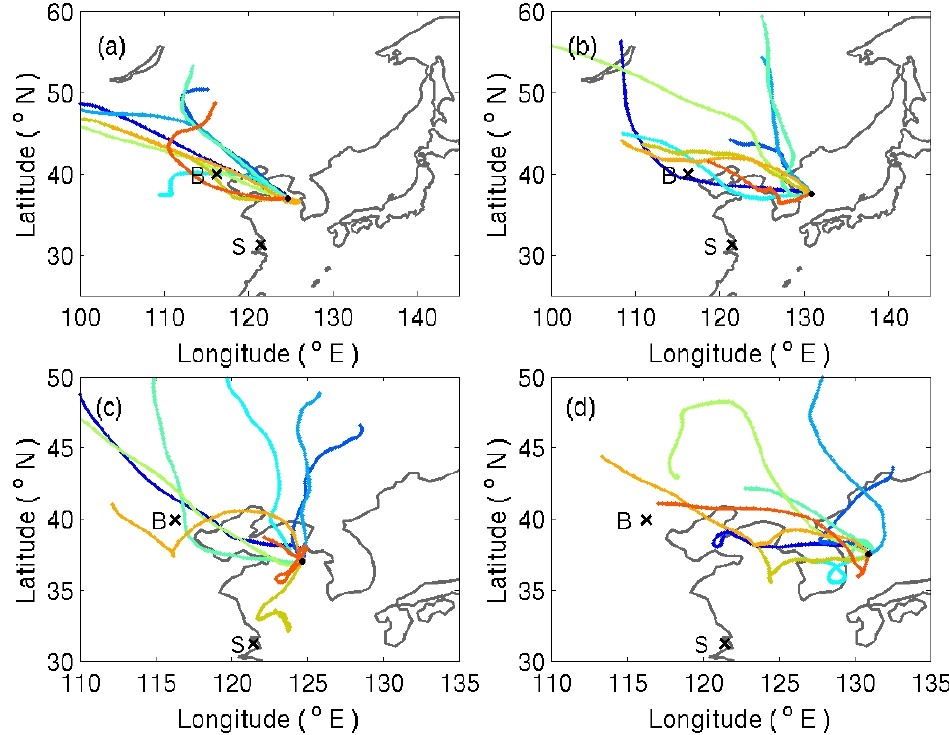
Figure 7. A 3-day back trajectory of airmass arriving at 2000 m ( a , b ) and 500 m ( c , d ) over the Yellow Sea ( a , c ) and East Sea ( b , d ) for the nine flights in [19]. The figures were created by the author. The 500 m and 2000 m were chosen to represent the heights within and above the PBL, respectively. The same color was used for the same flight.